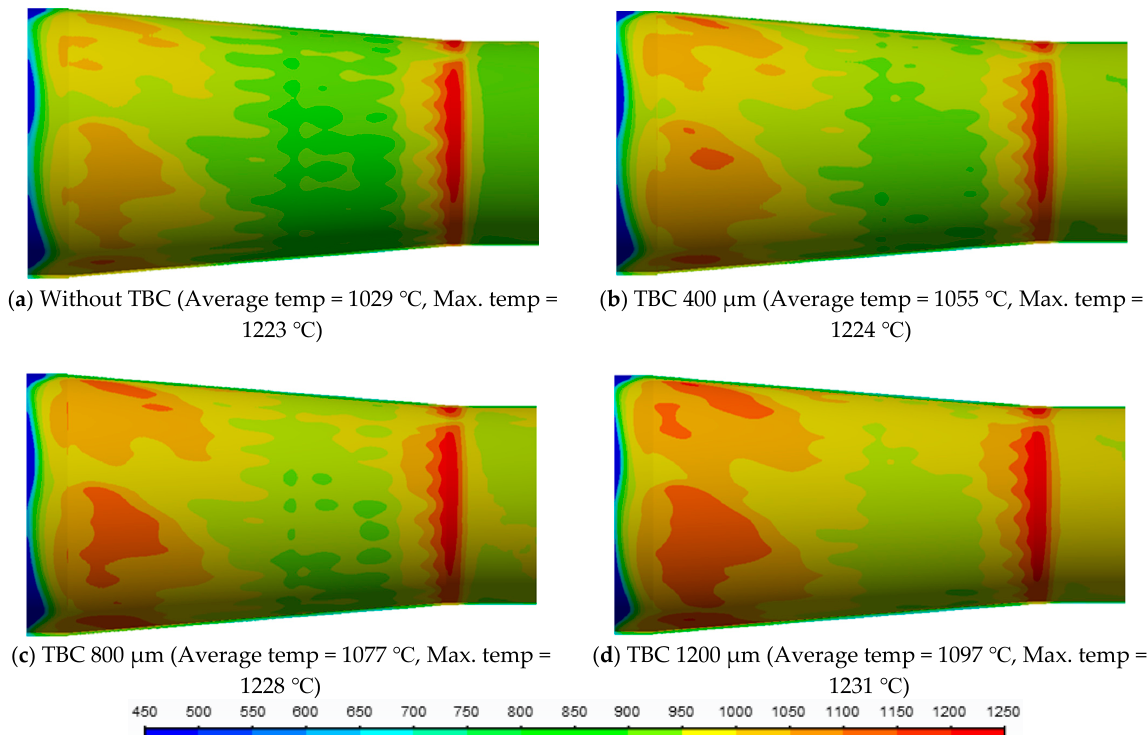
Figure 11. TBC surface temperature distribution based on the TBC thickness exposed to hot gas. Figure 12 shows the inner CL metal surface distribution based on the different TBC thicknesses on the combustion side. By increasing the TBC thickness, the metal surface temperature of the CL was reduced to 912 °C (1200 μ m TBC case) from 1029 °C (without TBC). When comparing the maximum temperatures, a similar trend was observed. When the contours in Figures 11 and 12 were compared based on TBC thickness between the TBC surface and metal surface, the metal temperature was reduced due to the low thermal conductivity of YSZ. Thus, the increasing TBC thickness provided good thermal protec- tion. Furthermore, as TBC thickness increased, the larger hotspot with a higher tempera- ture became merely a uniform reduced temperature distributed over the entire metal in- ner surface. However, the metal surface near the C-channel of the 1200 μ m case had a higher temperature than the other two shell sections (forward and center) in Figure 12d, but a lower temperature than the other TBC cases in Figure 12a–c. The uniform distribu- tion of the wall temperature can help to mitigate the structural damage.